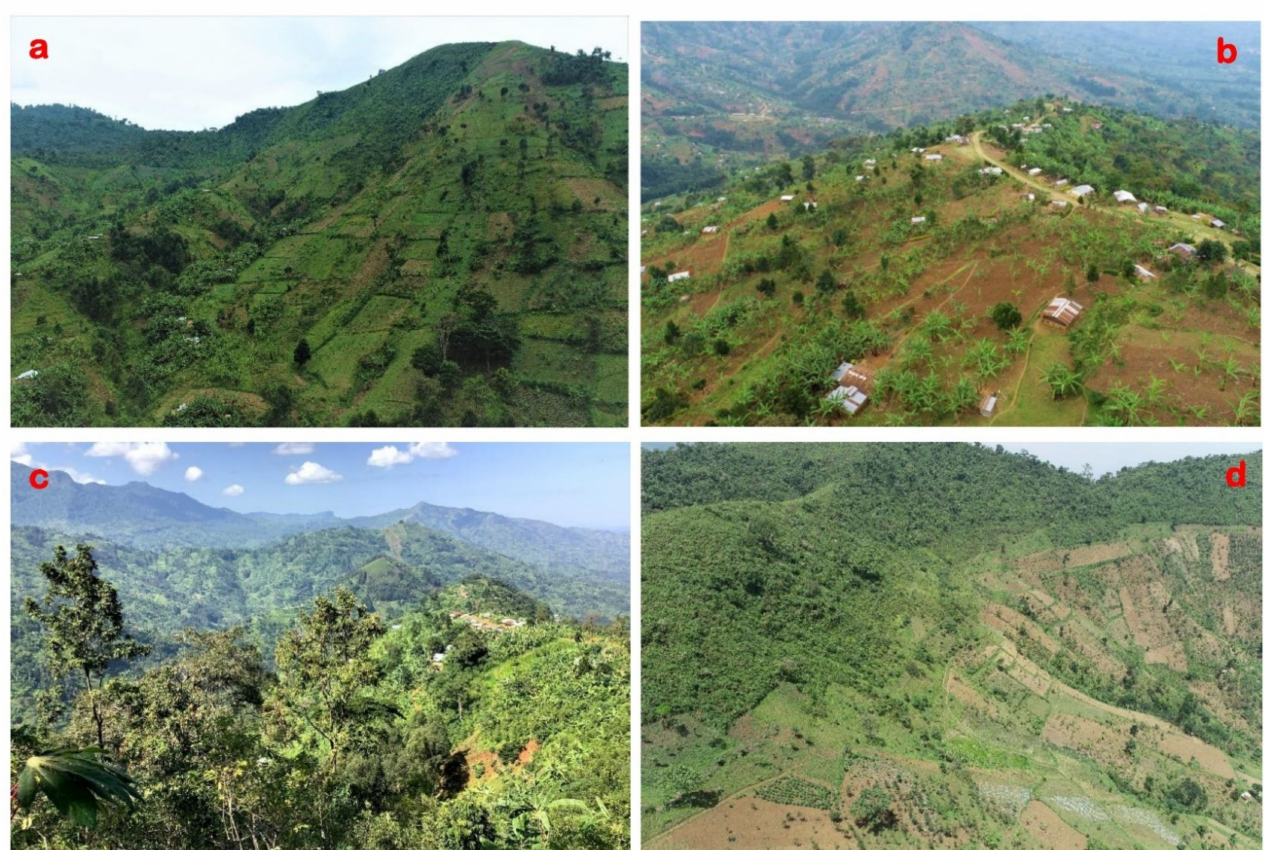
Figure 2. Selected photographic view of the land use and land cover in the study area during ground visits to the sample locations: ( a ) agriculture at the periphery of the park, ( b ) built-up and agriculture, ( c ) intensively cultivated slopes with planted forests and landslide scars, and ( d ) the heterogeneity of land cover types and park